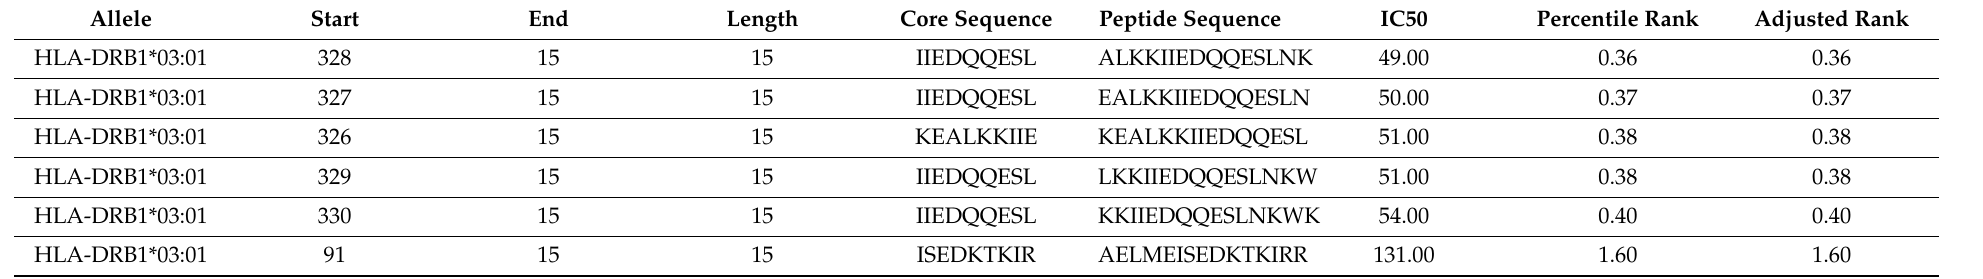
Table 6. HLA-DR3 allele with predicted peptides of human